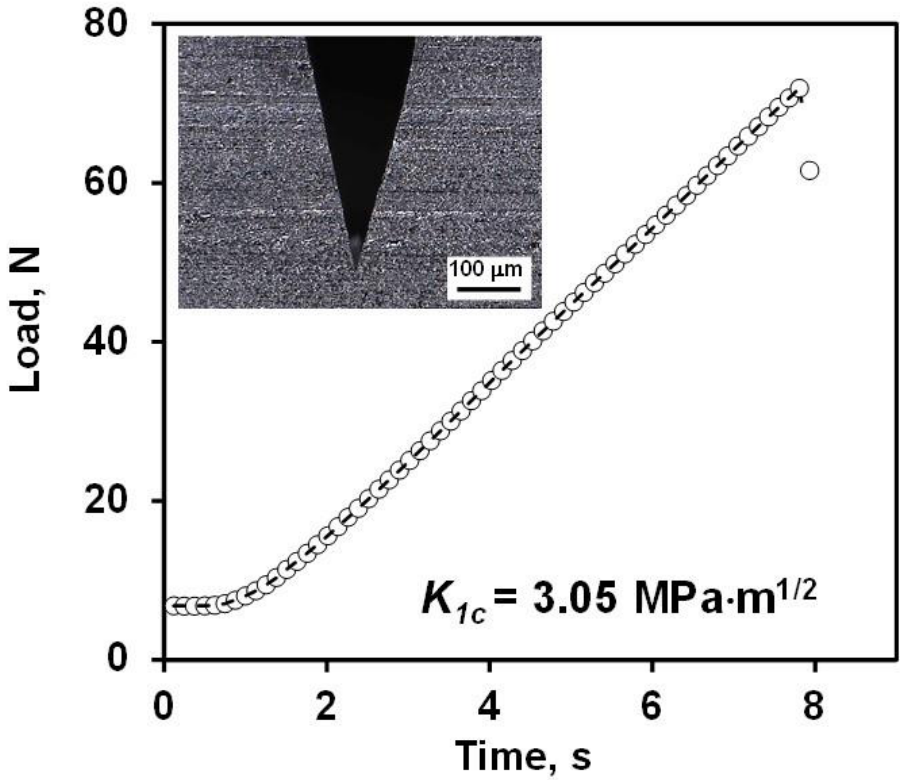
Figure 12. Load vs. time plot of B 4 C V notched bar used for the calculation of fracture toughness. The insert is an optical micrograph of the V notch.